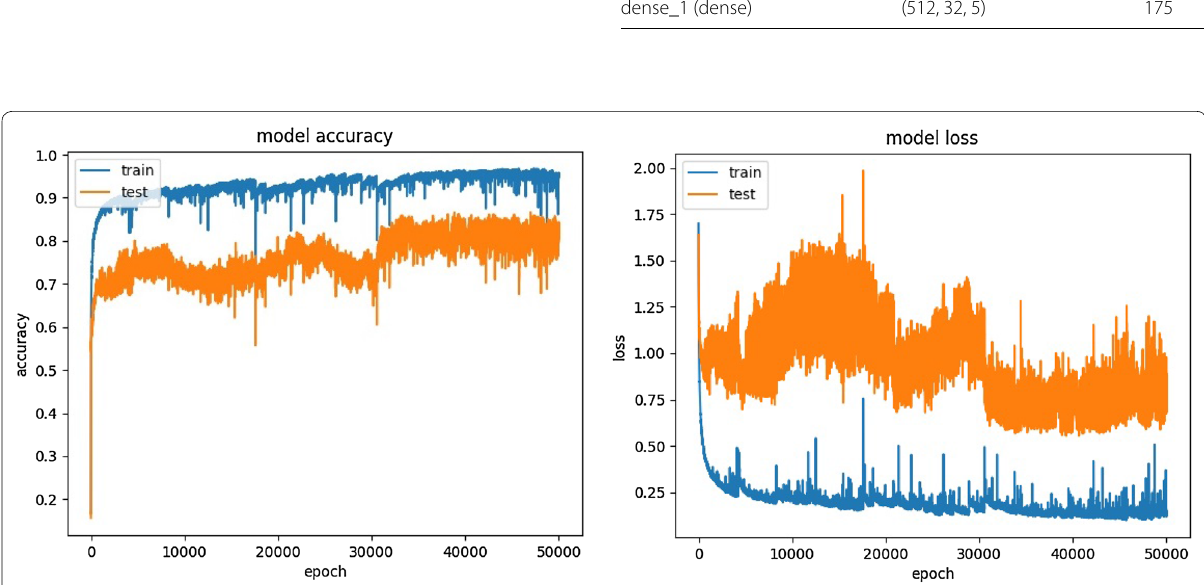
Fig. 7 The model accuracy and loss over 50,000 iterations